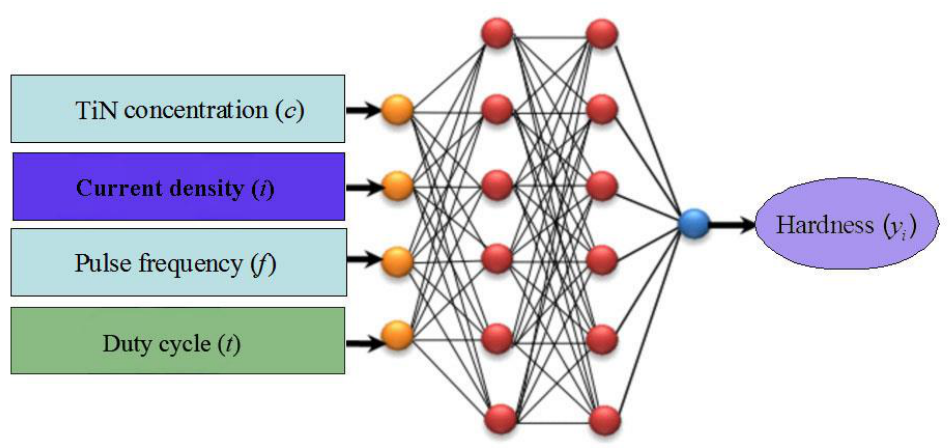
Figure 3. Schematic image of the backward propagation (BP) neural network model.